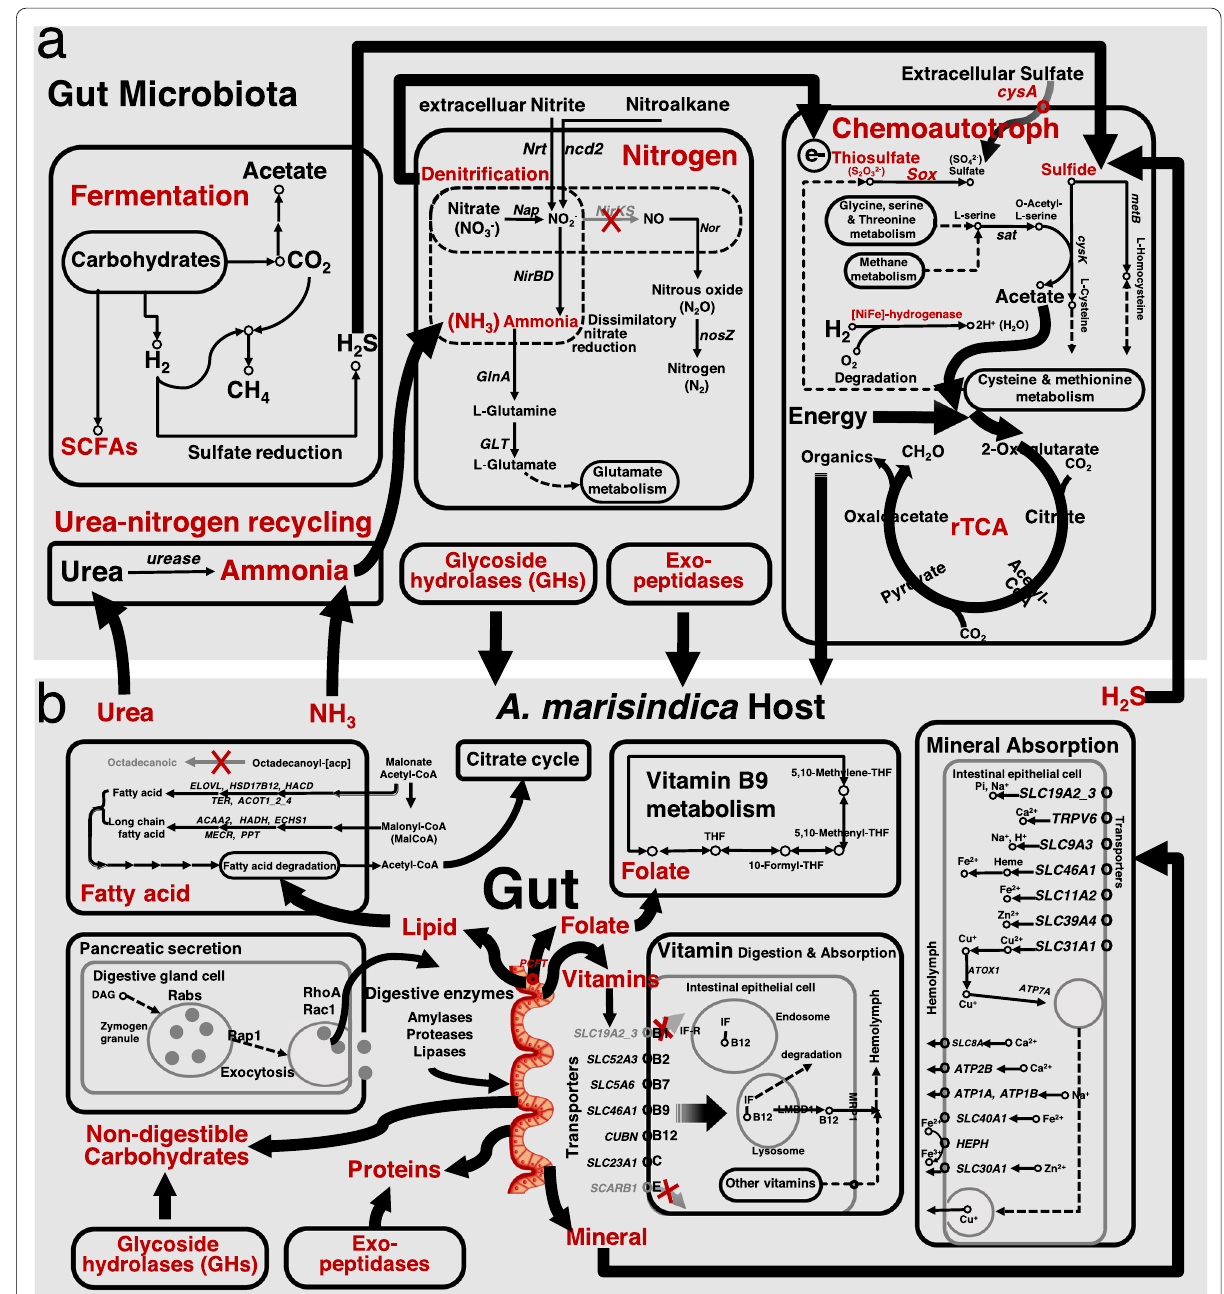
Fig. 4 Overview of meta‑pathways of Alviniconcha marisindica and its gut microbiome. Metabolic pathways of different organisms, including a the gut microbiome and b A. marisindica host, are presented to reveal the functional contribution of gut microbiomes to the host. Important metabolic intermediates and complementary intermediate products are indicated in red